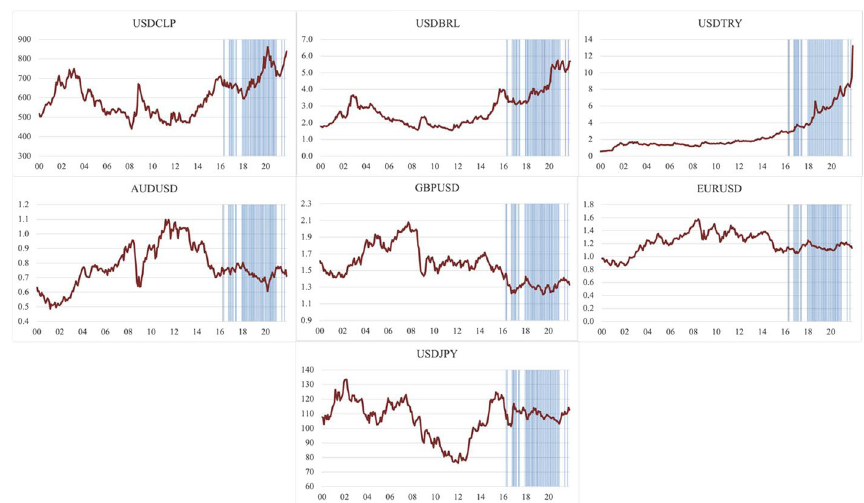
Fig. 5 Historical exchange rates under normal and high levels of TPU. The shaded areas correspond to periods of high TPU. The threshold is defined by the 75 th percentile of the sample, which is at level 47, approximately